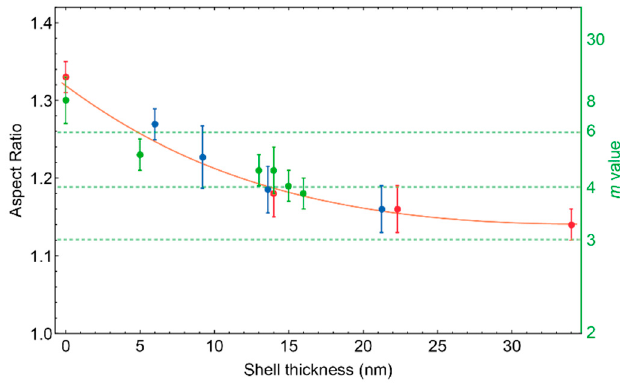
Figure 10. Influence of the relative shell thickness to the aspect ratio of the particles. The data points on the left (shell thickness 0 nm) are the core particles. On the right Y axis the corresponding m -values are indicated. Dotted lines are drawn for m = 3, m = 4 (highest m value obtained with the heamatite method [4]) and m = 6 (highest m value obtained in this study). The orange curve is to guide the eye.